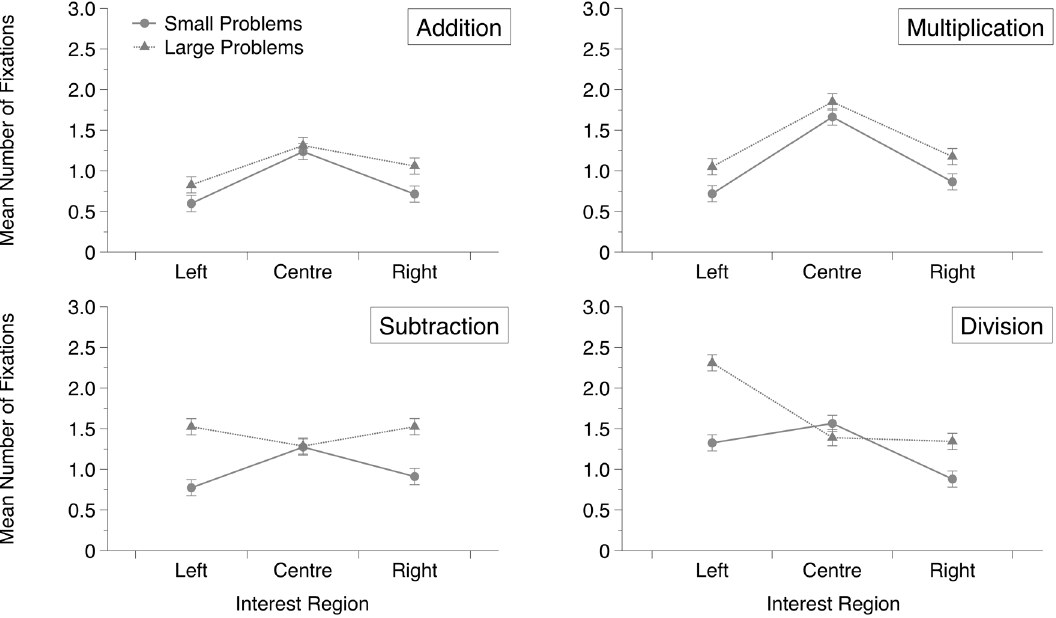
Figure 3. Mean number of fixations as a function of operation, problem size, and interest area. Error bars represent 95% confidence